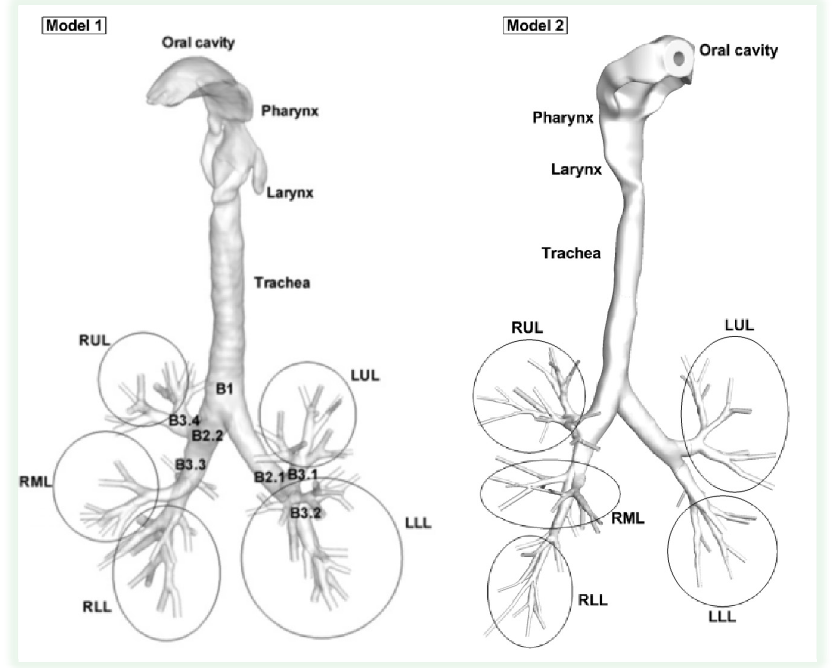
Figure 1. Configuration of subject-specific human airway models (from oral cavity to